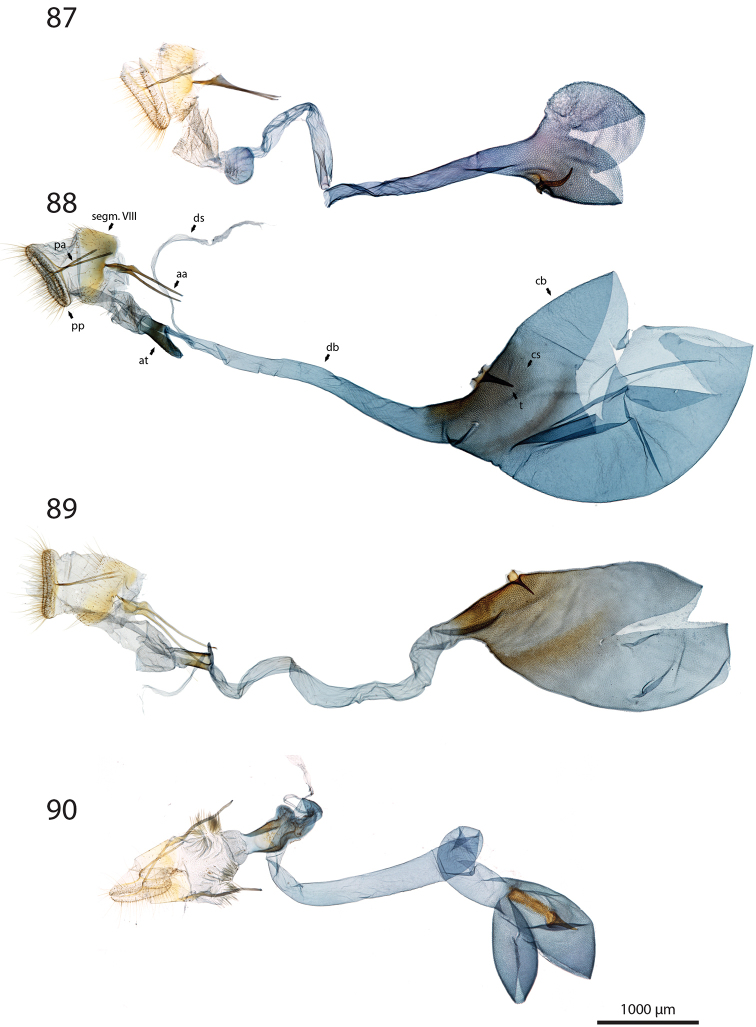
Female genitalia features of Hoploscopa. 87Hoploscopa
albipuncta sp. nov., paratype, TL609 ♀ 88Hoploscopa
matheae sp. nov., paratype, TL599 ♀ 89Hoploscopa
sepanggi sp. nov., paratype, TL547 ♀ 90Hoploscopa
cynodonta sp. nov., paratype, TL625 ♀. Abbreviations: aa (anterior apophyses), at (antrum), cb (corpus bursae), cs (corpus sclerotization), db (ductus bursae), ds (ductus seminalis), pa (posterior apophyses), pp (papillae anales), segm. VIII (segment VIII), t (thorn).